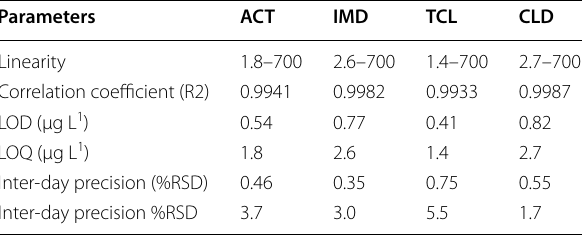
Table 3 Analytical performance of the developed